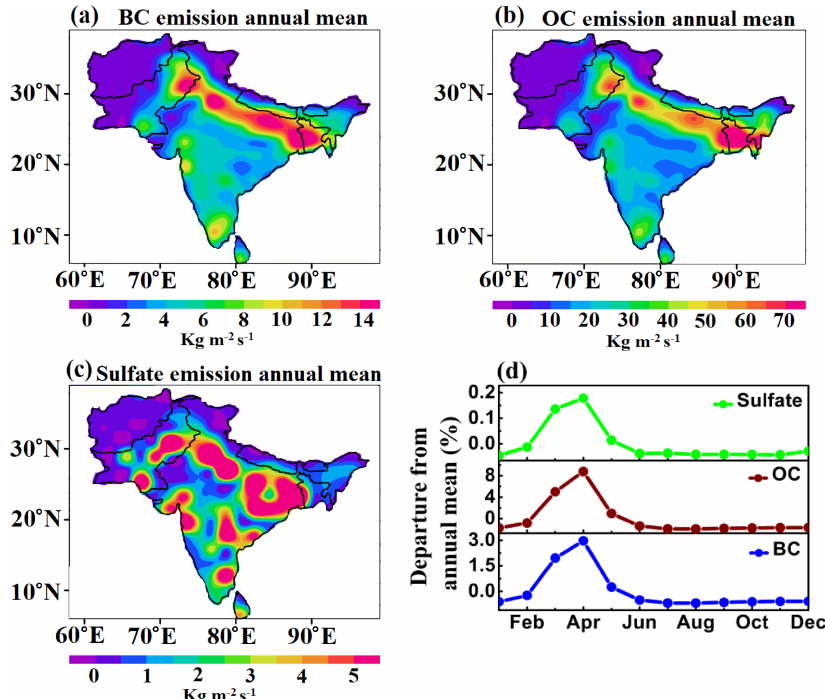
Figure 1. Spatial distribution for the year 2016 annual mean total emission (kgm − 2 s − 1 ) of (a) BC, (b) OC, and (c) sulfate aerosols from the AEROCOM-ACCMIP-II emission inventory and (d) time series of monthly departure from annual mean total emissions (%) of BC, OC, and sulfate aerosols averaged over the Indo-Gangetic Plain (23–30 ◦ N, 78–90 ◦